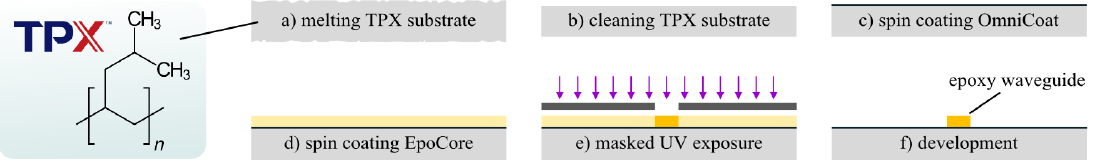
Figure 1. Schematic fabrication process of the flexible epoxy-based Bragg grating mechanical sensor device using high-elastic TPX™ substrate material.